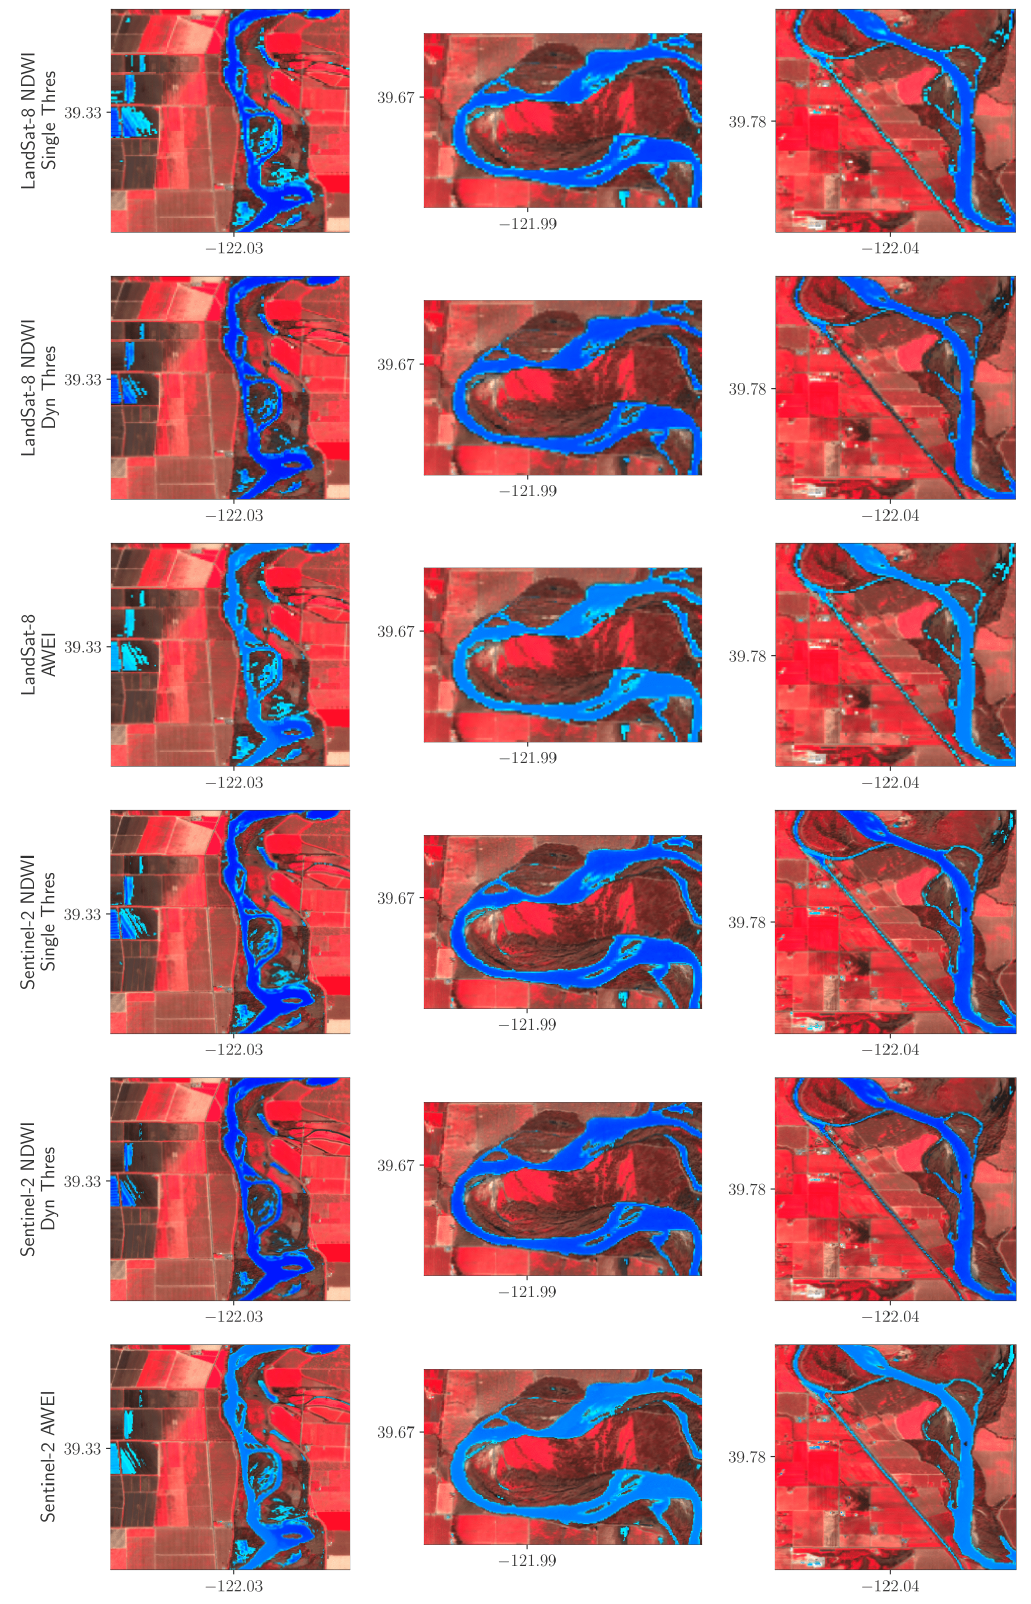
Figure 8. Classified wetted pixels (blue areas) for the 16 March 2019 high-flow event at three specific locations along the mid-Sacramento River using the different indices, remote imagery products, and methodologies. Lighter blue represents shallower water areas.